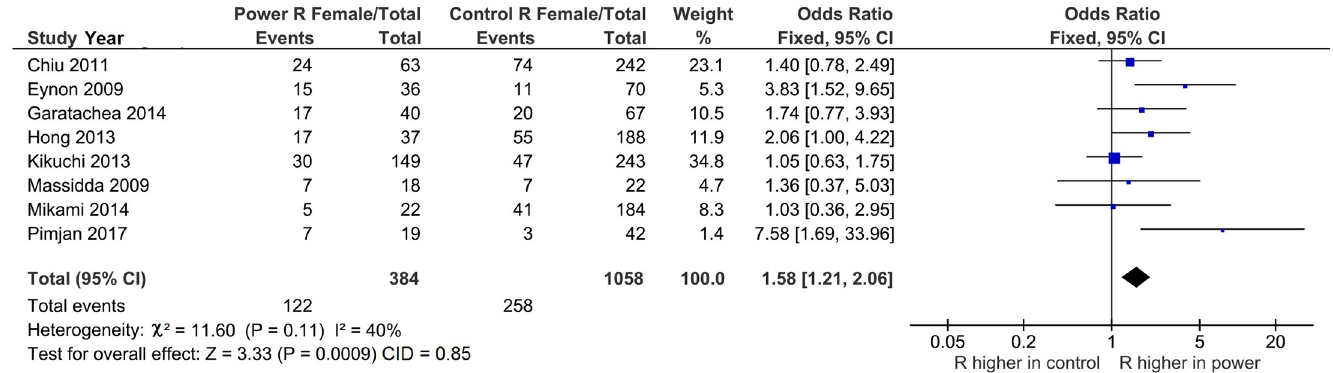
Fig 5. Forest plot of the R allele female effects in the post-outlier analysis. R: wild-type; CI: confidence interval; P: P-value; χ 2 : chi-square; CID: confidence interval difference.